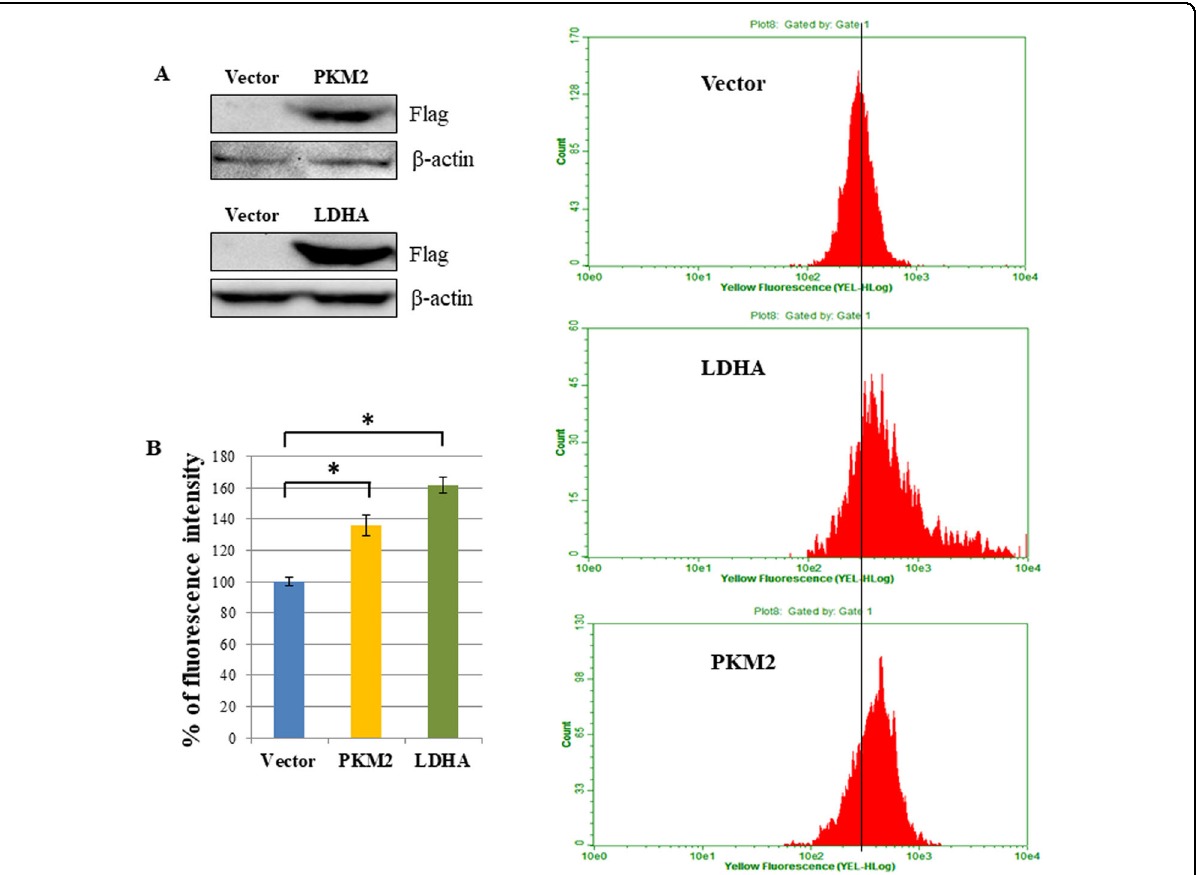
Fig. 8 The overexpression of PKM2 and LDHA in H1299 cells increase mitochondrial membrane potential. A . Western-blot of H1299 cells transfected by PKM2-encoding and LDHA-encoding vectors. B , C The fl ow cytometry of MitoTracker fl uorescence of PKM2 and LDHA overexpressing H1299 cells. Three biological replicates were used for all quanti fi cations, data are presented as mean ± S.D., * P <